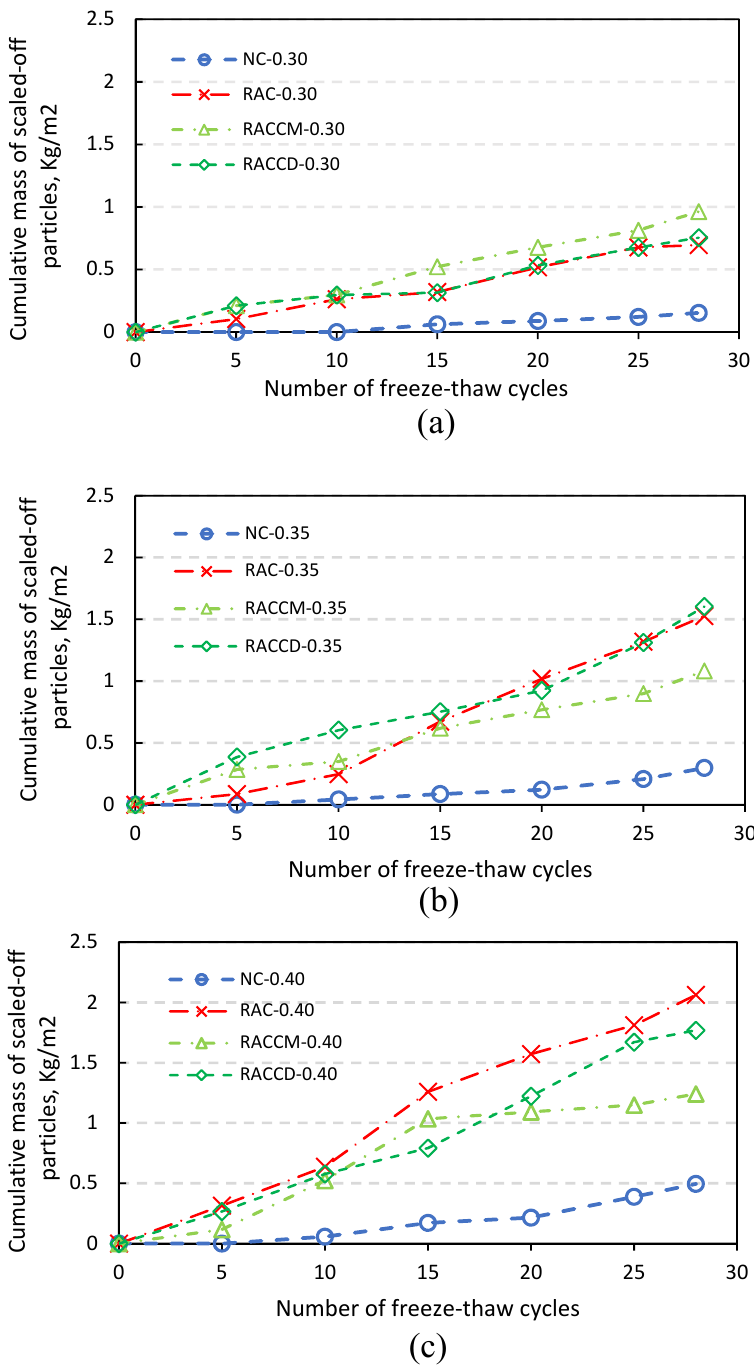
Figure 9. Cumulative mass of scaled-off residues of mixes: ( a ) w/c 0.30, ( b ) w/c 0.35, and ( c ) w/c 0.40.